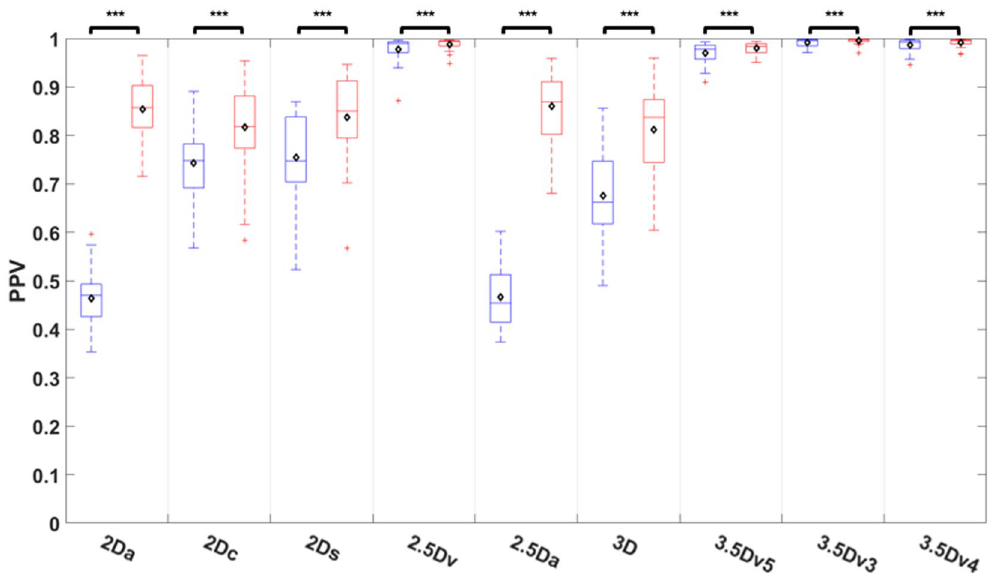
Figure 8. Comparison of positive predict value among 9 U-Nets before and after E&D.